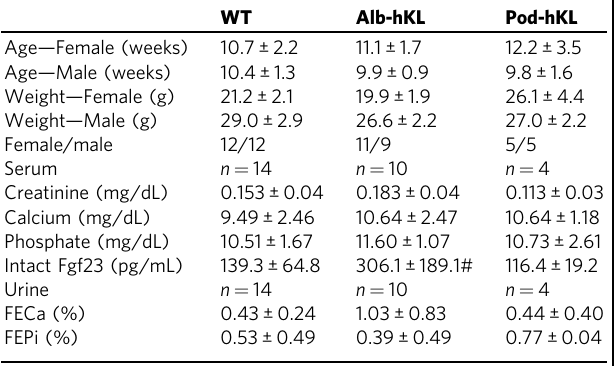
Table 1 General characteristics, serum, and urinary biochemistry in WT, Alb-hKL, and Pod-hKL mice at